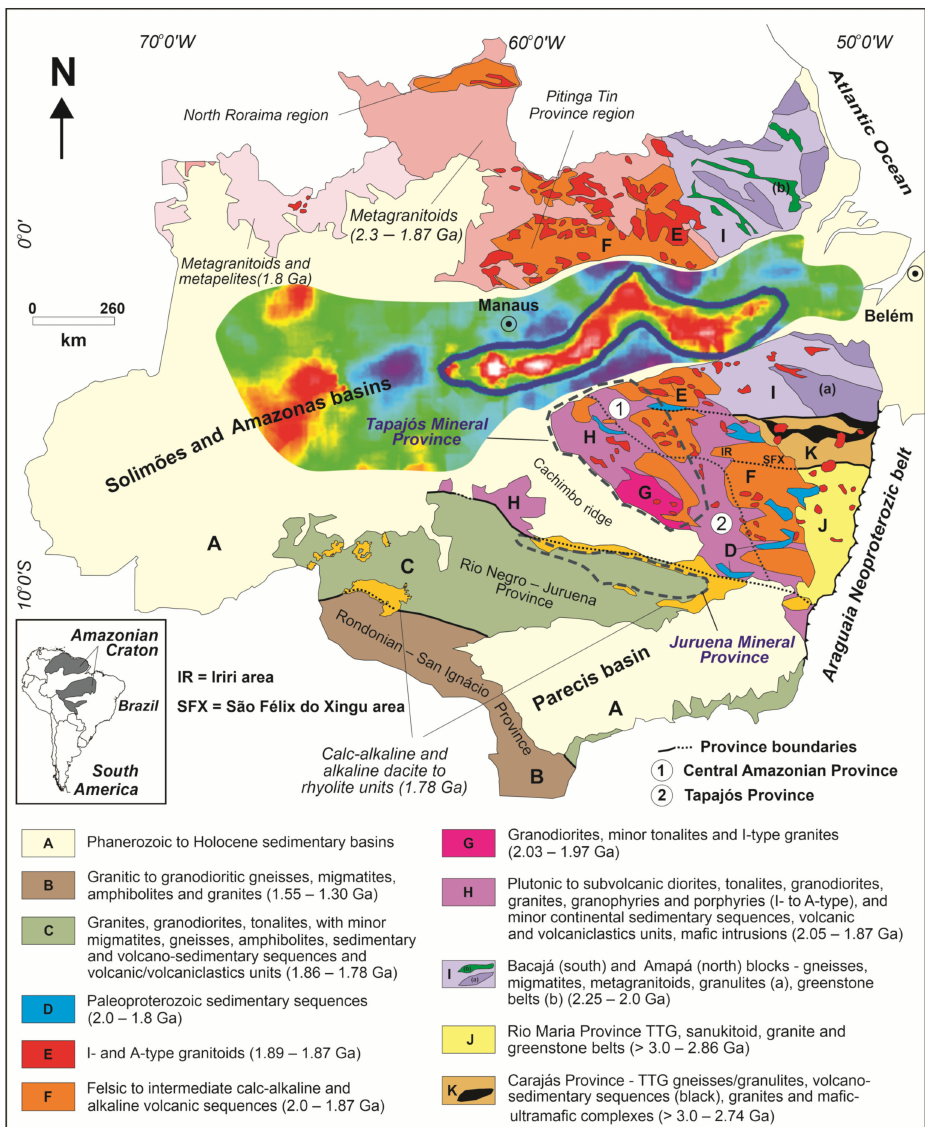
Figure 1. Geological and tectonic settings of the Tapaj ó s and Juruena mineral provinces in the Amazonian Craton, modified from [46]. Geochronological provinces based on [44]; tectonic domains by [5]. Gravimetry of Solim õ es and Amazonas basins, with main Bouguer anomaly defined by the blue line (variation from +60 to − 70 mGal, hot to cold colors) is from